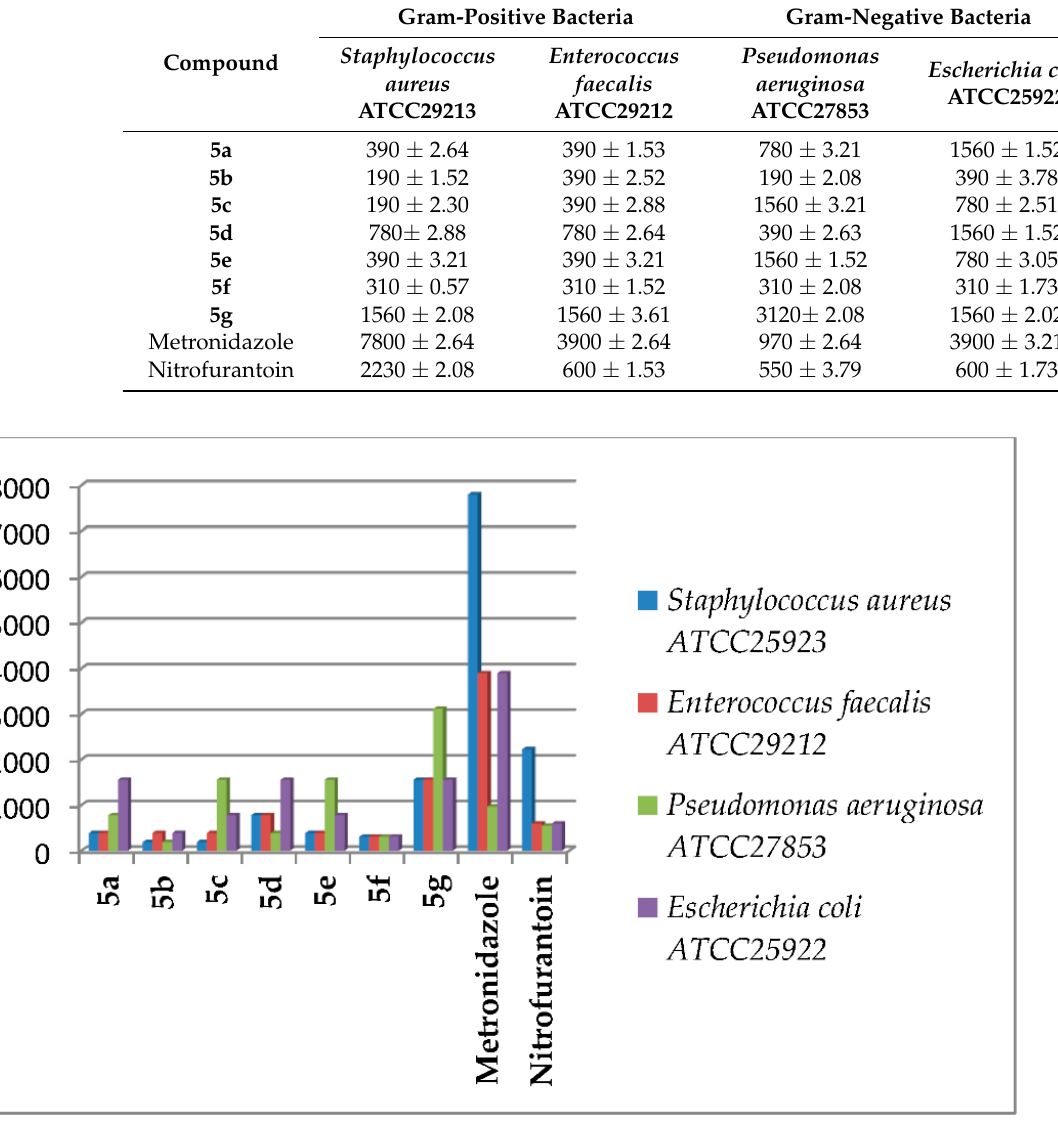
Figure 6. MIBC ( μ g/mL) values of the tested compounds. Figure 6. MIBC ( µ g/mL) values of the tested compounds. All 5a–g synthesized compounds show better anti-biofilm activity against the Staphy- lococcus aureus strain ATCC259234 compared to the reference drugs. The most active compound, 5f , was noted to inhibit a biofilm having an MBIC of 310 µ g/mL against all the bacterial strains, much lower compared to the reference drugs (Metronidazole, Nitrofu- rantoin). Also, compound 5b showed the best activity against Staphylococcus aureus strain ATCC259234 and Pseudomonas aeruginosa ATCC27853 with an MBIC of 190 µ g/mL, much lower compared to the reference drugs (Metronidazole,